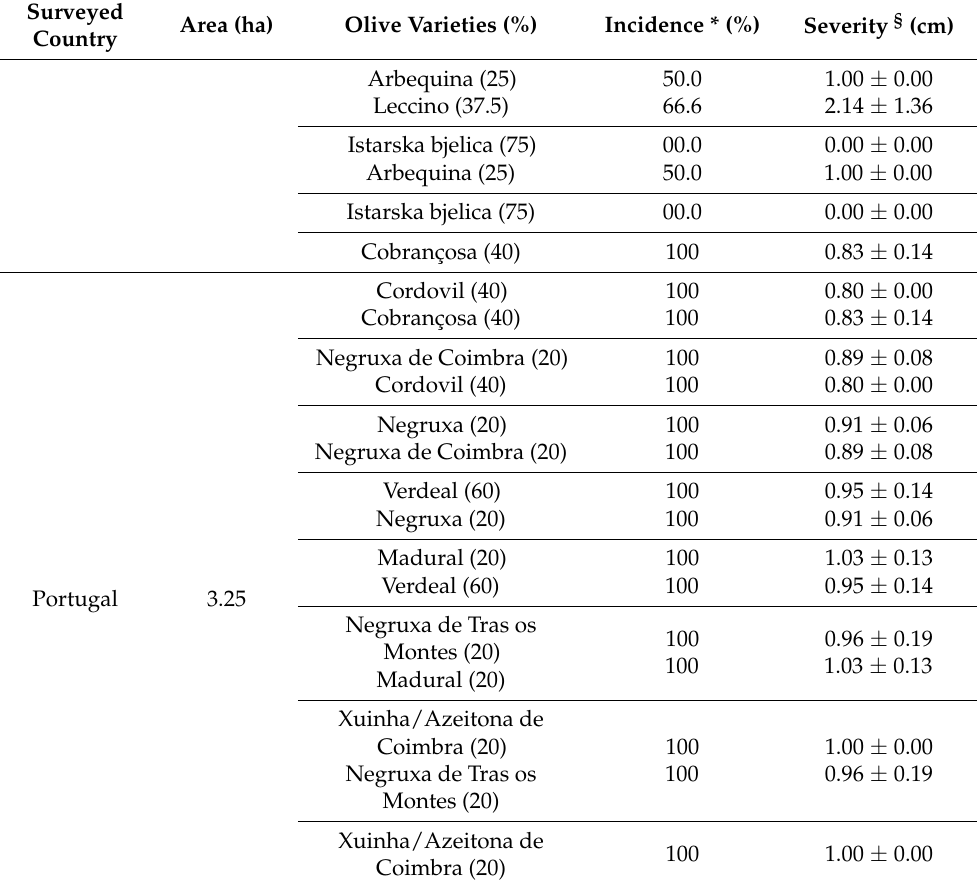
Table 1. Cont. Surveyed Area (ha) Olive Varieties Country